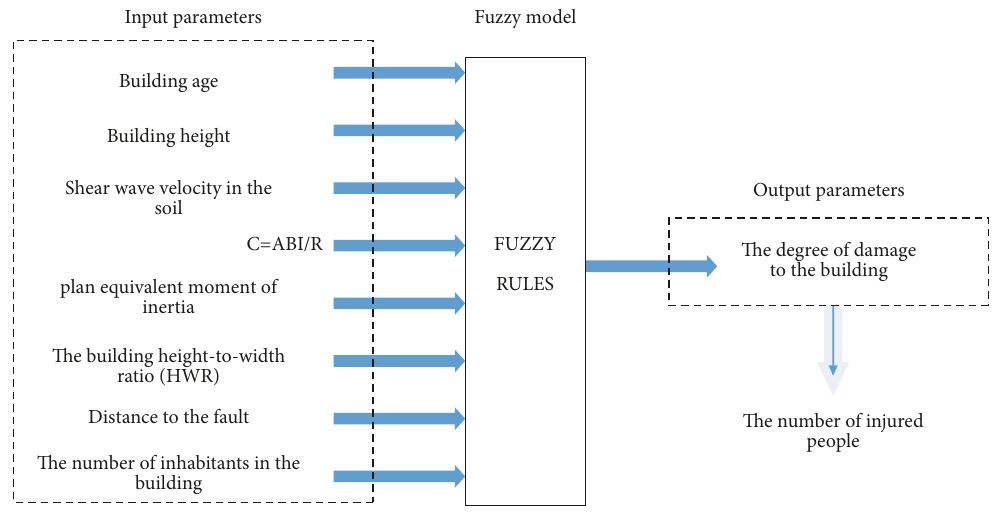
Figure 1: Flowchart of the fuzzy model sections and subsections.